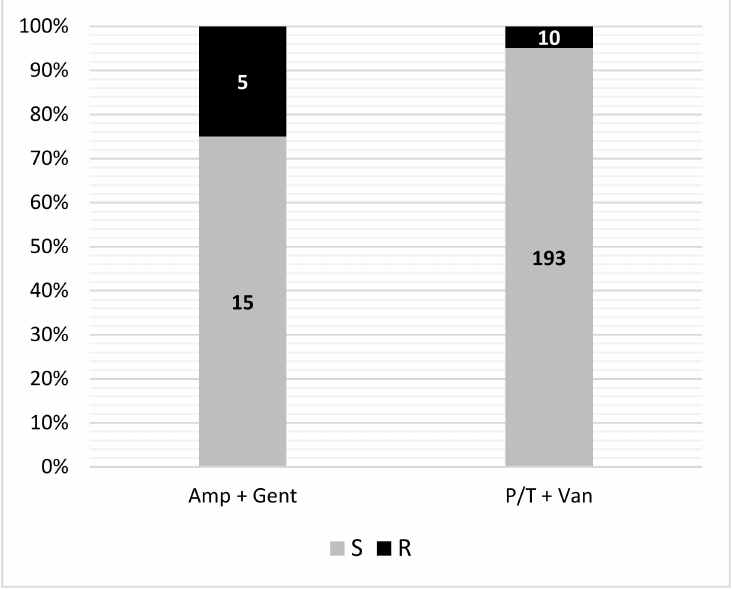
Figure 1. Sensitivity of isolates to LOS and EOS empiric therapy. S = documented sensitivity to at least one antibiotic. R = documented resistance to both antibiotics or documented resistance to one with the second not tested. CoNS were excluded from this